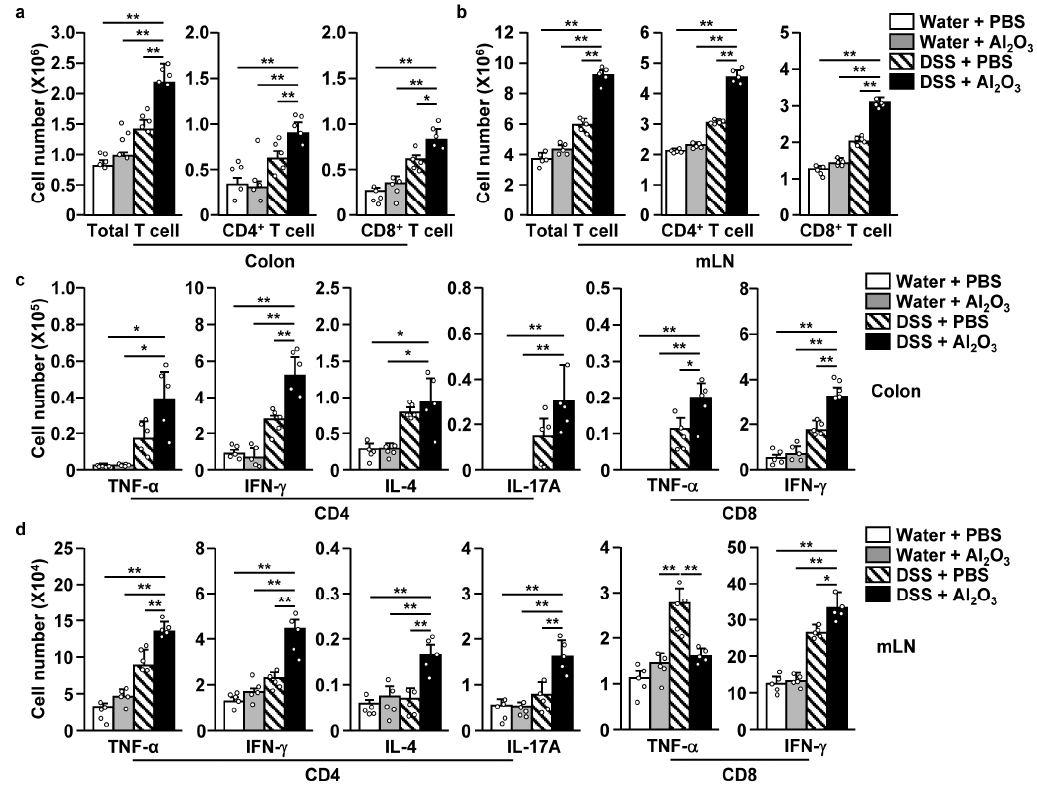
Figure 6. Al 2 O 3 FPs contributed in the T cell-mediated inflammatory responses. The C57BL/6 mice were treated with the DSS and Al 2 O 3 FPs as shown in Figure 5. ( a ) Total numbers of colon infiltrated T cells, CD4 T cells and CD8 T cells. ( b ) The number of total T cells, CD4 T cells and CD8 T cells in mLNs. ( c ) The numbers of cytokine producing CD4 and CD8 T cells in colon. ( d ) Intracellular cytokine-producing CD4 and CD8 T cells in the mLNs ( n = 5, two-way ANOVA, mean ± SEM). * and ** represent p < 0.05 and p < 0.01, respectively.